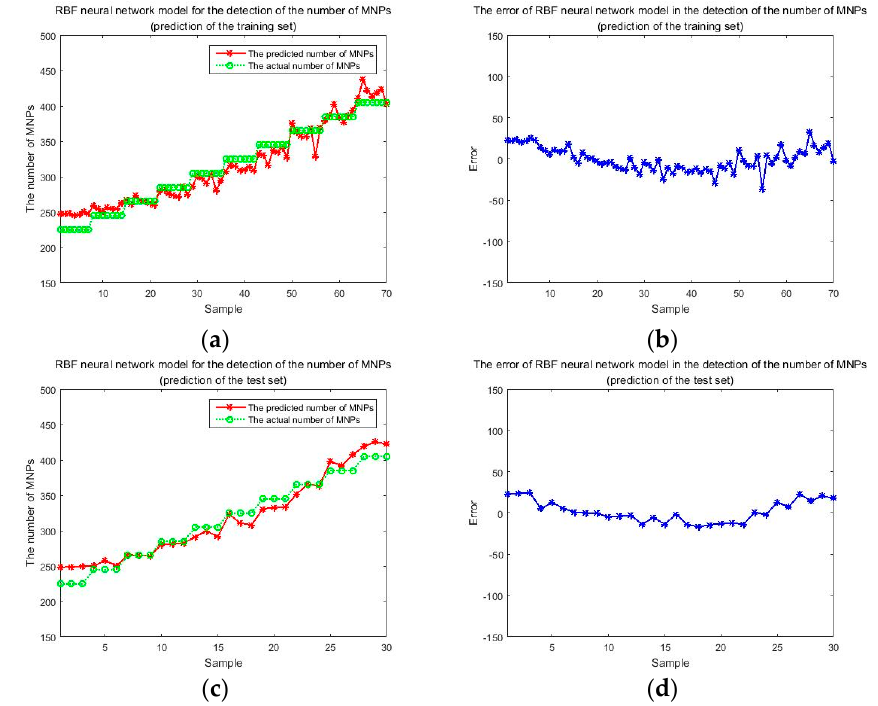
Figure 15. MNPs number detection model based on Radial Basis Function neural network (RBFNN): ( a ) the prediction results of RBFNN model for the training set, ( b ) the prediction error of RBFNN model for the training set, ( c ) the prediction results of RBFNN model for the test set, and ( d ) the prediction error of RBFNN model for the test set.